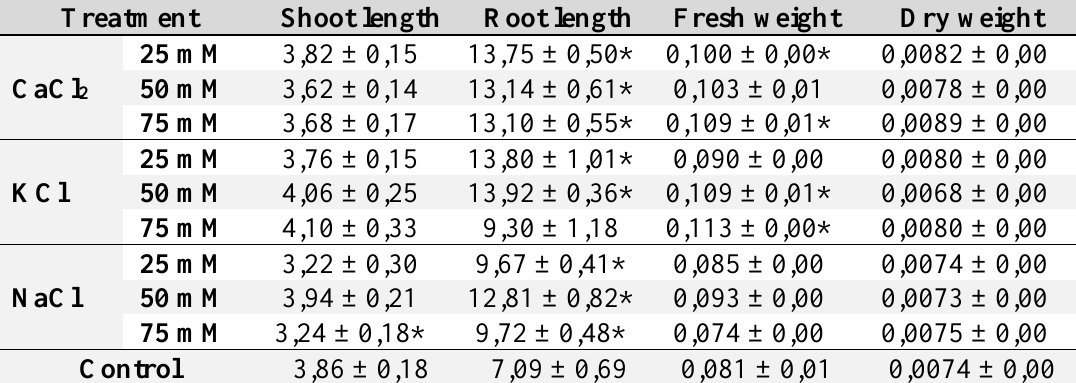
Table 4. Effect of halopriming on shoot and root length (cm) and weight (g) of Raphanus sativus L .